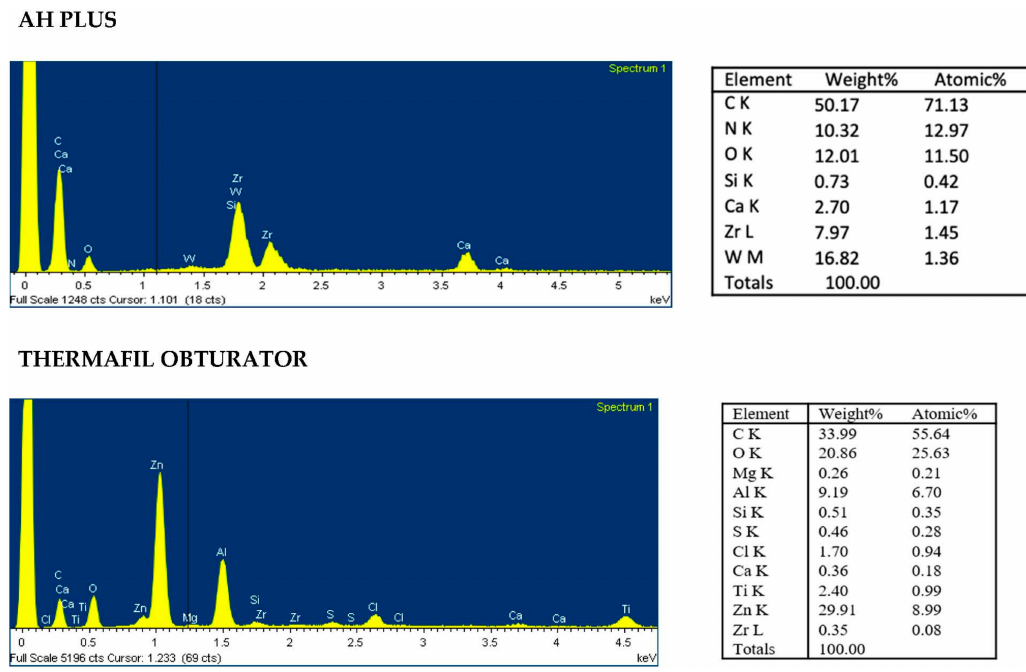
Figure 3. EDX spectra of sealer and carrier used in the present